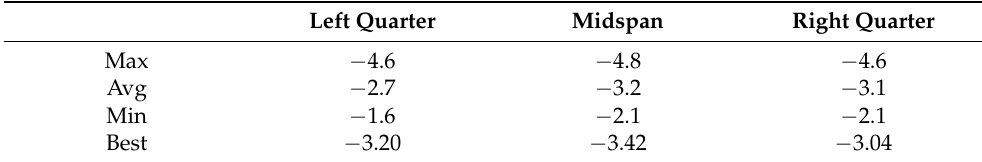
Table 6. Deformation tracking based on GPA-ICP.